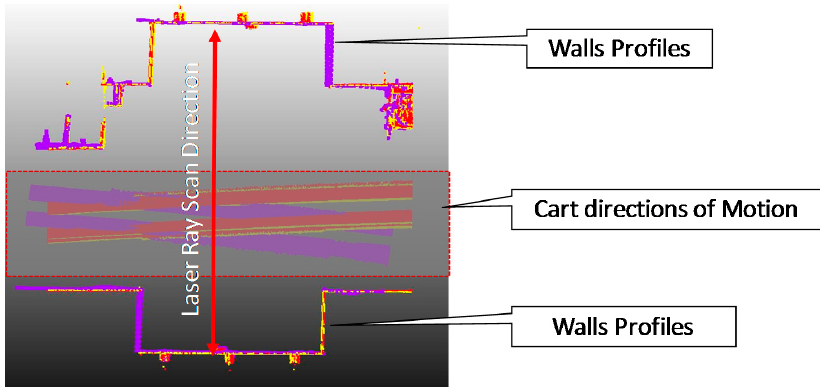
Figure 9. Results of dynamic scans performed with two different directions of motion of the cart.